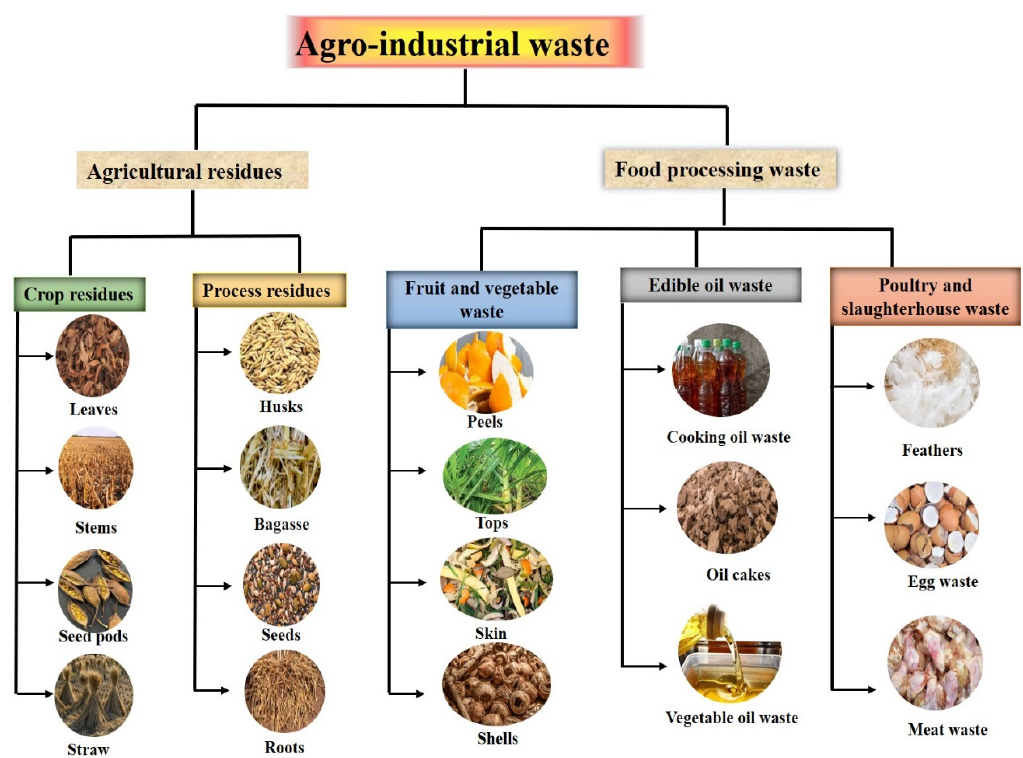
Figure 3. Classification of different types of agro-industrial food waste.